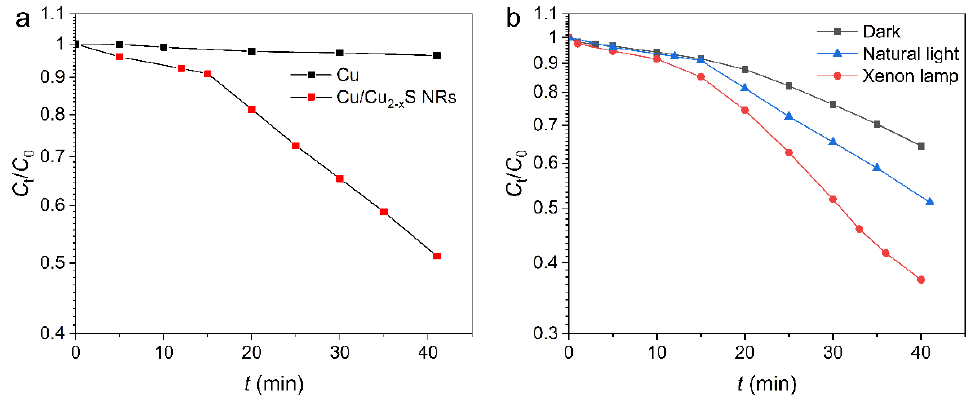
Figure 7. Logarithmic plots of C t / C 0 as a function of time for MO degradation by ( a ) Cu and Cu/Cu 2 − x S NRs under natural light, ( b ) Cu/Cu 2 − x S NRs under three irradiation conditions (dark, Cu/Cu 2−x S NRs under natural light, ( b ) Cu/Cu 2−x S NRs under three irradiation conditions (dark, nat- natural light and xenon ural light and xenon lamp).